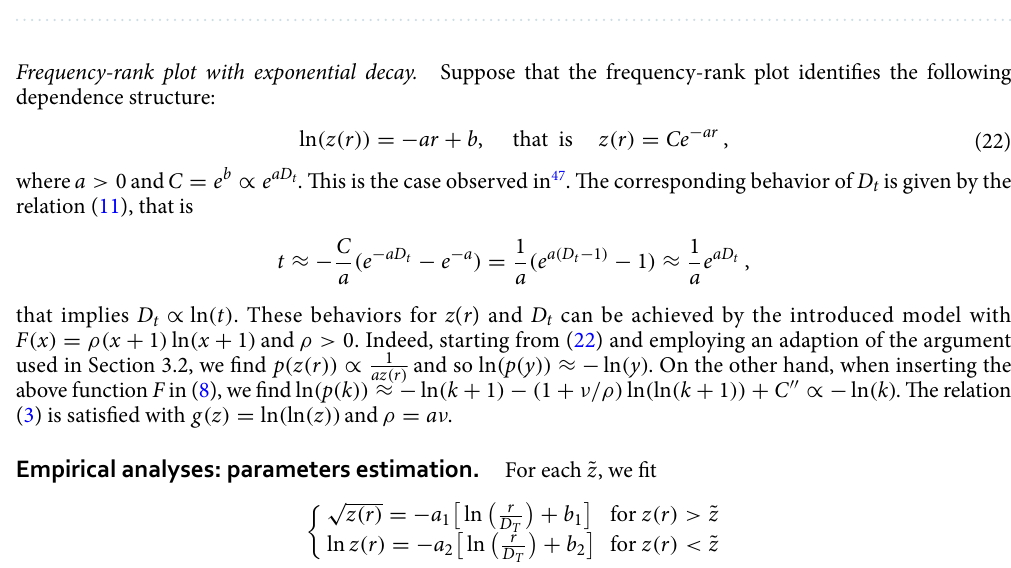
Figure 7. Estimation of the parameter z